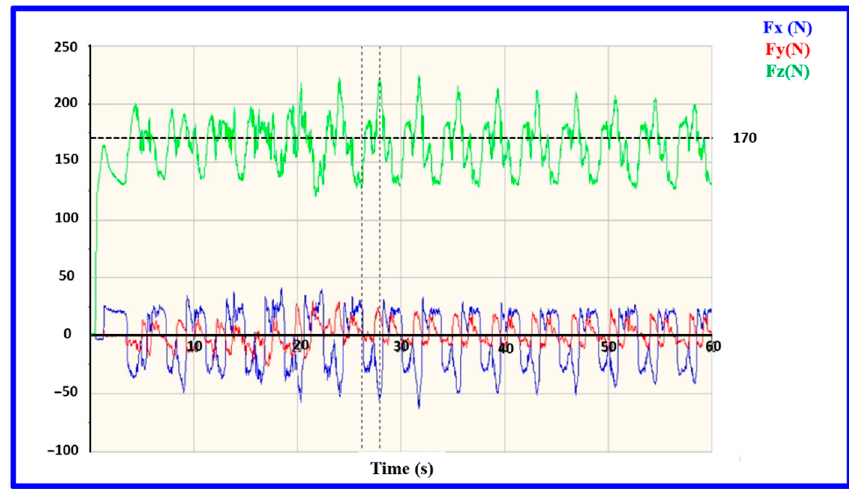
Figure 3. Vertical load (F z ) and radial friction force (Fx and Fy) during BB.